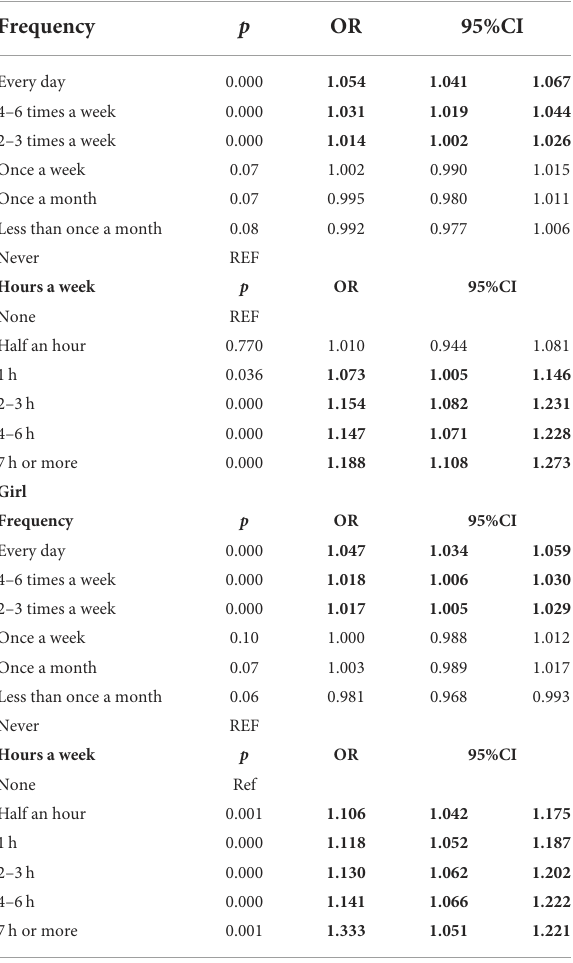
TABLE 2 Association between vigorous physical activity and life satisfaction by gender. Boy